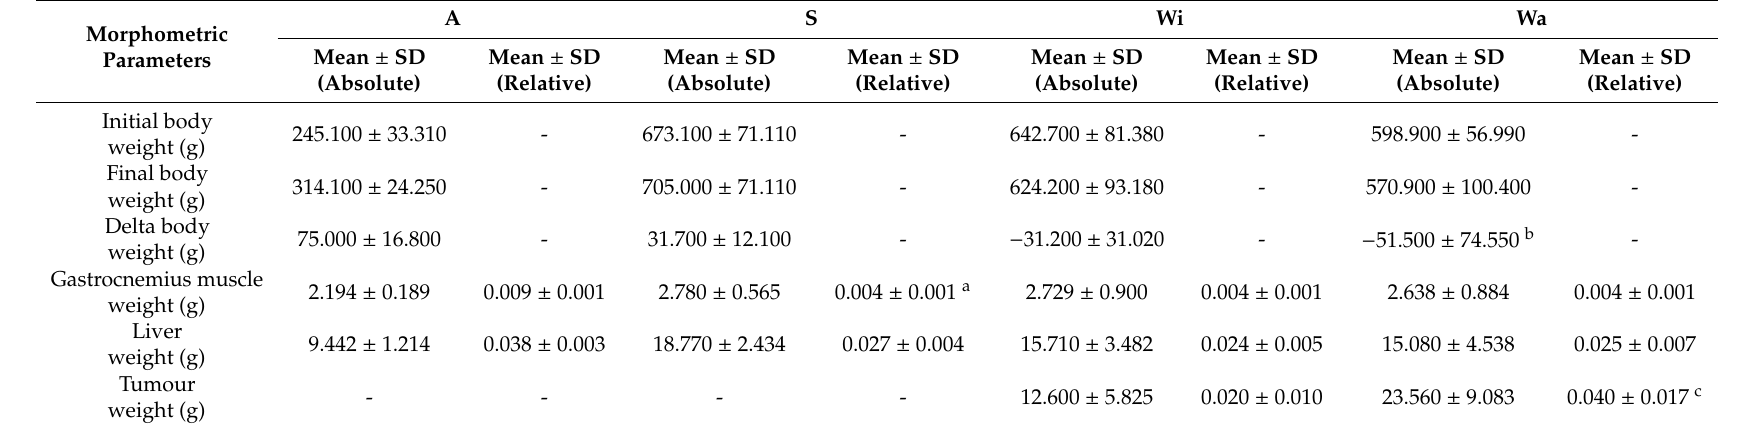
Table 1. Morphometric parameters identified in adult, ageing and ageing Walker 256 tumour-bearing